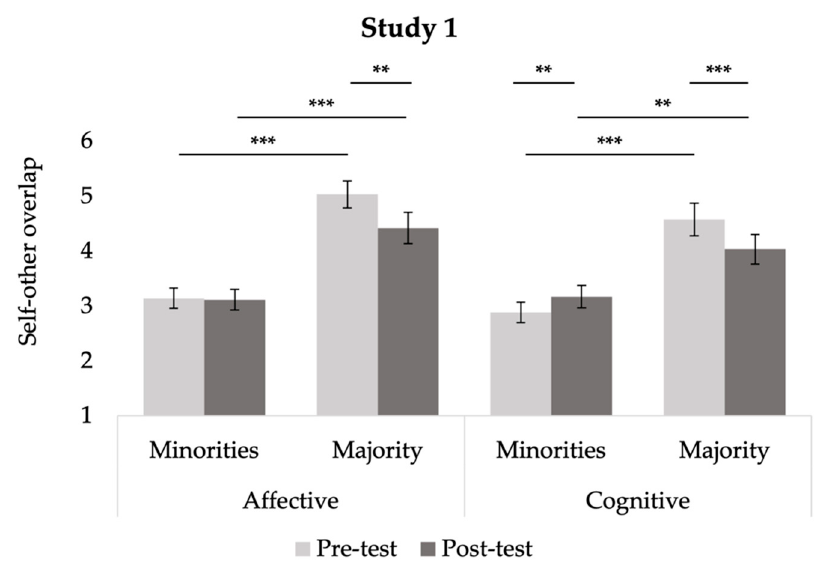
Figure 3. Plot depicting participants’ self-other overlap with minorities and majorities at pre-test and post-test within each condition in Study 1. * p < 0.05, ** p < 0.01, *** p < 0.001. Perspective-Taking